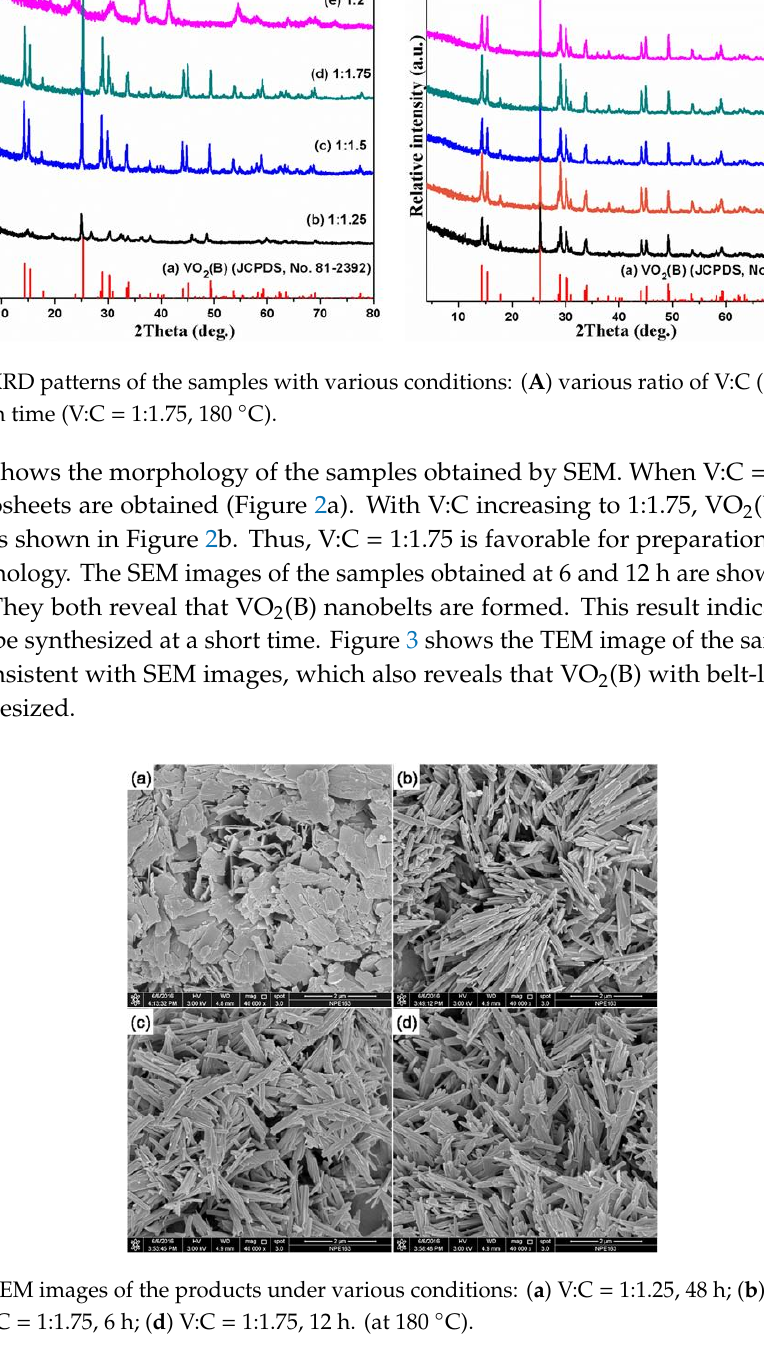
Figure 3. TEM images of the VO 2 (B) nanobelts at different scales: (a) 500 nm; (b) 200 nm. Further composition and structure information about the as ‐ obtained VO 2 (B) was provided by EDS, FTIR, and Raman. The SEM image and its corresponding EDS spectrum of the as ‐ obtained sample is shown in Figure 4, which indicates that the sample composes of vanadium and oxygen elements in consonance with the observation of XRD patterns. The IR and Raman spectra of the as ‐ obtained VO 2 (B) is shown in Figure 5a. The absorption peaks among 1100 and 400 cm − 1 are assigned to V ‐ O vibration band in the IR spectrum [ Error! Reference source not found. , Error! Reference source not found. ]. The peak at 535 cm − 1 is ascribed to the stretching modes of V ‐ O ‐ V, and that at 920 cm − 1 is ascribed to V ‐ O bonds. Meanwhile, the characteristic absorption peak of the VO 2 (B) nanobelts with layered structure is observed at 998 cm − 1 , which is assigned to the symmetric stretching vibration in VO 2 (B) (V 4+ = O).